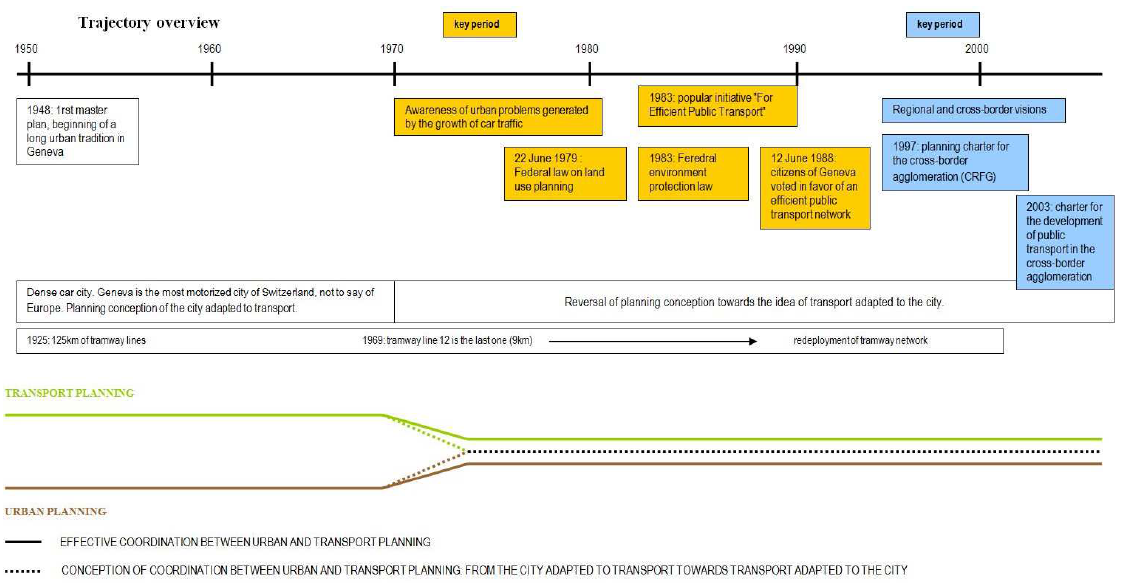
Figure 1. Trajectory of the coordination between urban and transport planning in